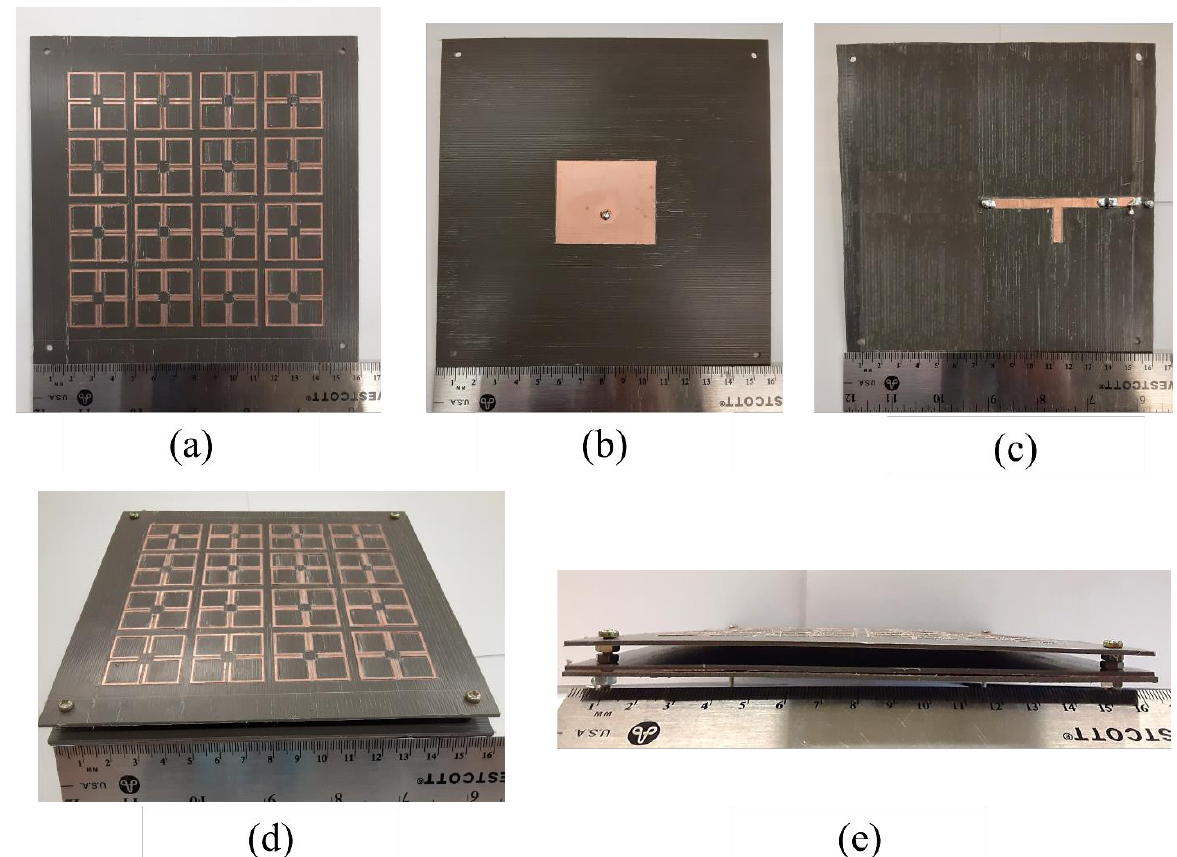
Figure 7. ( a ) Fabricated MTM superstrate, ( b ) fabricated patch antenna, ( c ) fabricated rectifier, ( d ) fabricated MTM-integrated rectenna, ( e ) side view of the fabricated MTM-integrated rectenna.